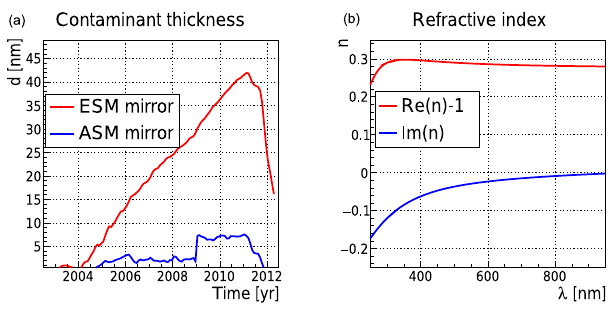
Figure 10. (a) Time dependence of contaminant layer thicknesses as determined from in-flight calibration data; red: ESM mirror; blue: ASM mirror. (b) The real (red, Re(n) − 1 is plotted) and imag- inary (blue) part of the refractive index of the contaminant vs. wave-